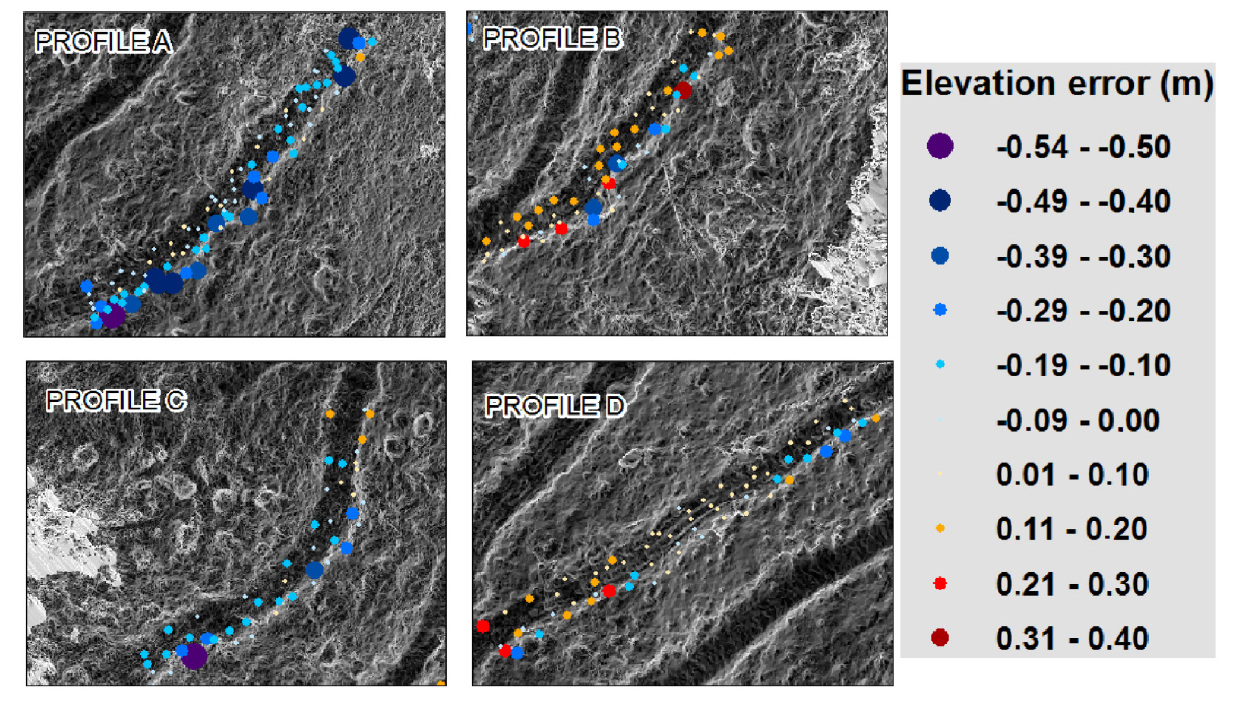
Figure 2. The location of DGPS reference points with the elevation error in meters shown by their respective colors.